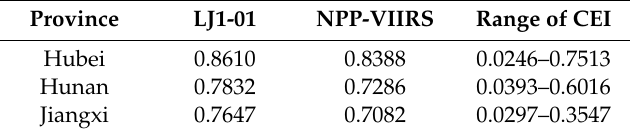
Table 10. The accuracy of the RF regression (R 2 ) in the Hubei, Hunan and Jiangxi